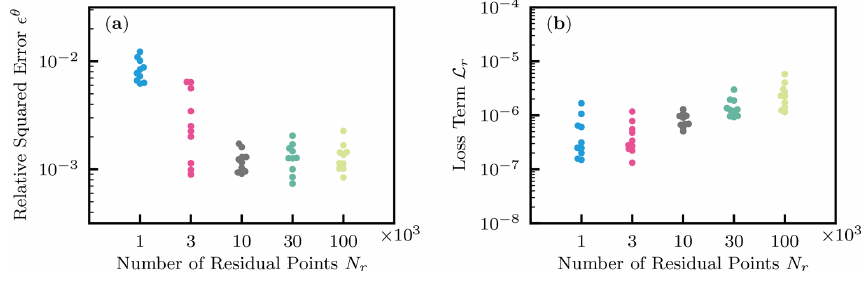
Figure 8. Homogeneous soil. (a) The effect of the number of residual points N r on the relative squared error (cid:15) θ . (b) The effect on the loss term for the residual L r